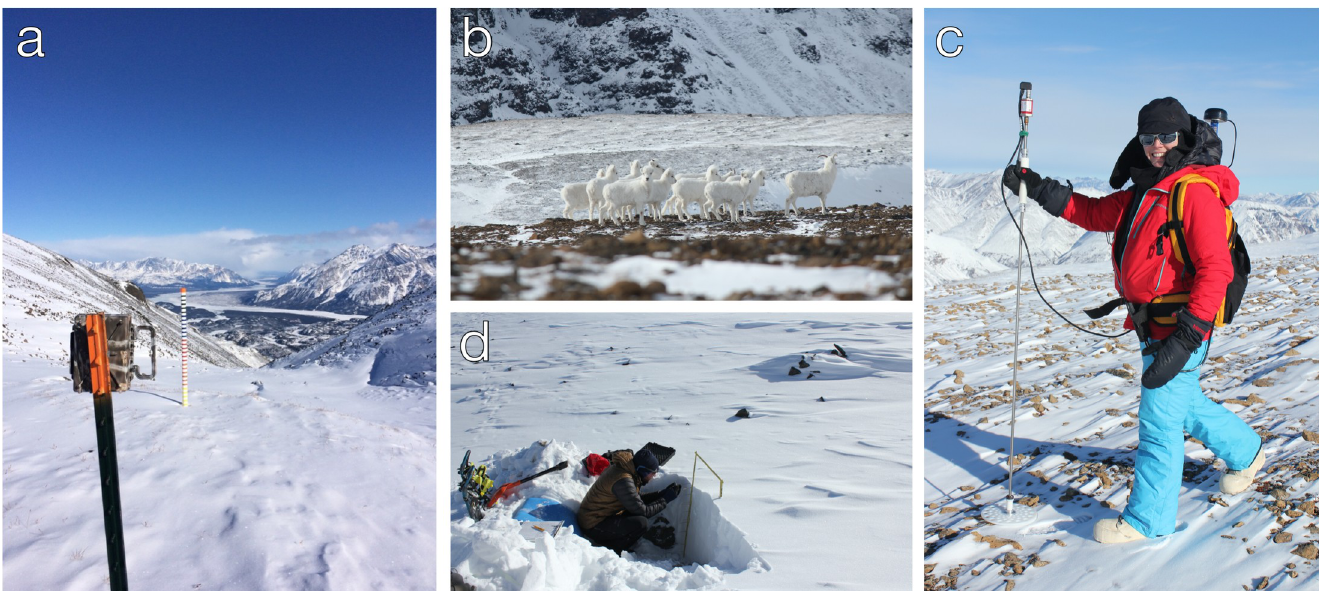
Fig 2. (a) Remote camera and snow stake installation looking northeast to the Nabesna river from Jaeger Mesa on 20th March 2017. Note the wind-blown, snow free areas on the slopes to the immediate sides of the snow stake. Photo C. Cosgrove. (b) Nursery band of Dall’s sheep on Jaeger Mesa. (c) Laura Prugh operating the Magnaprobe to survey snow depth atop Jaeger Mesa. Photo Anne Nolin. (d) Chris Cosgrove surveying a snow pit for stratigraphy, temperature and density profile. Photo L. Prugh. The individuals in this manuscript have given written informed consent (as outlined in PLOS consent form) to publish these